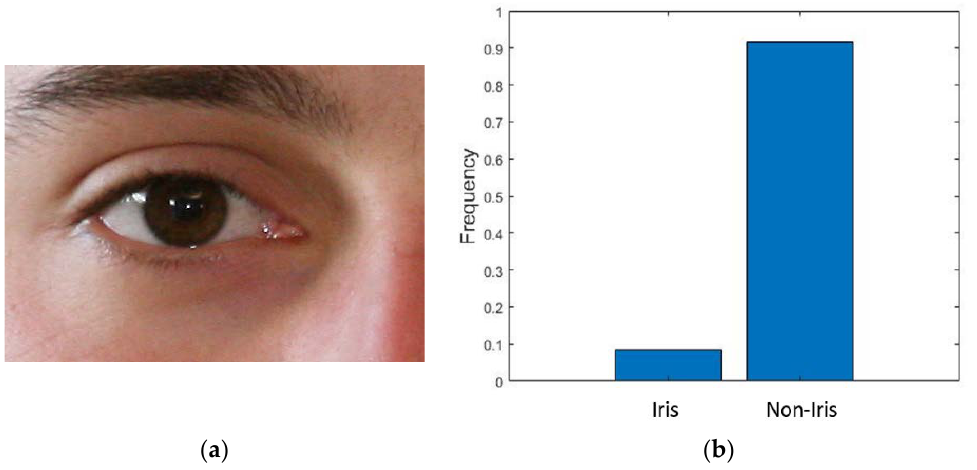
Figure 6. Difference in frequency between iris and non-iris classes. ( a ) NICE-II original input image. ( b ) Difference in frequency of iris and non-iris pixels in NICE-II training dataset.